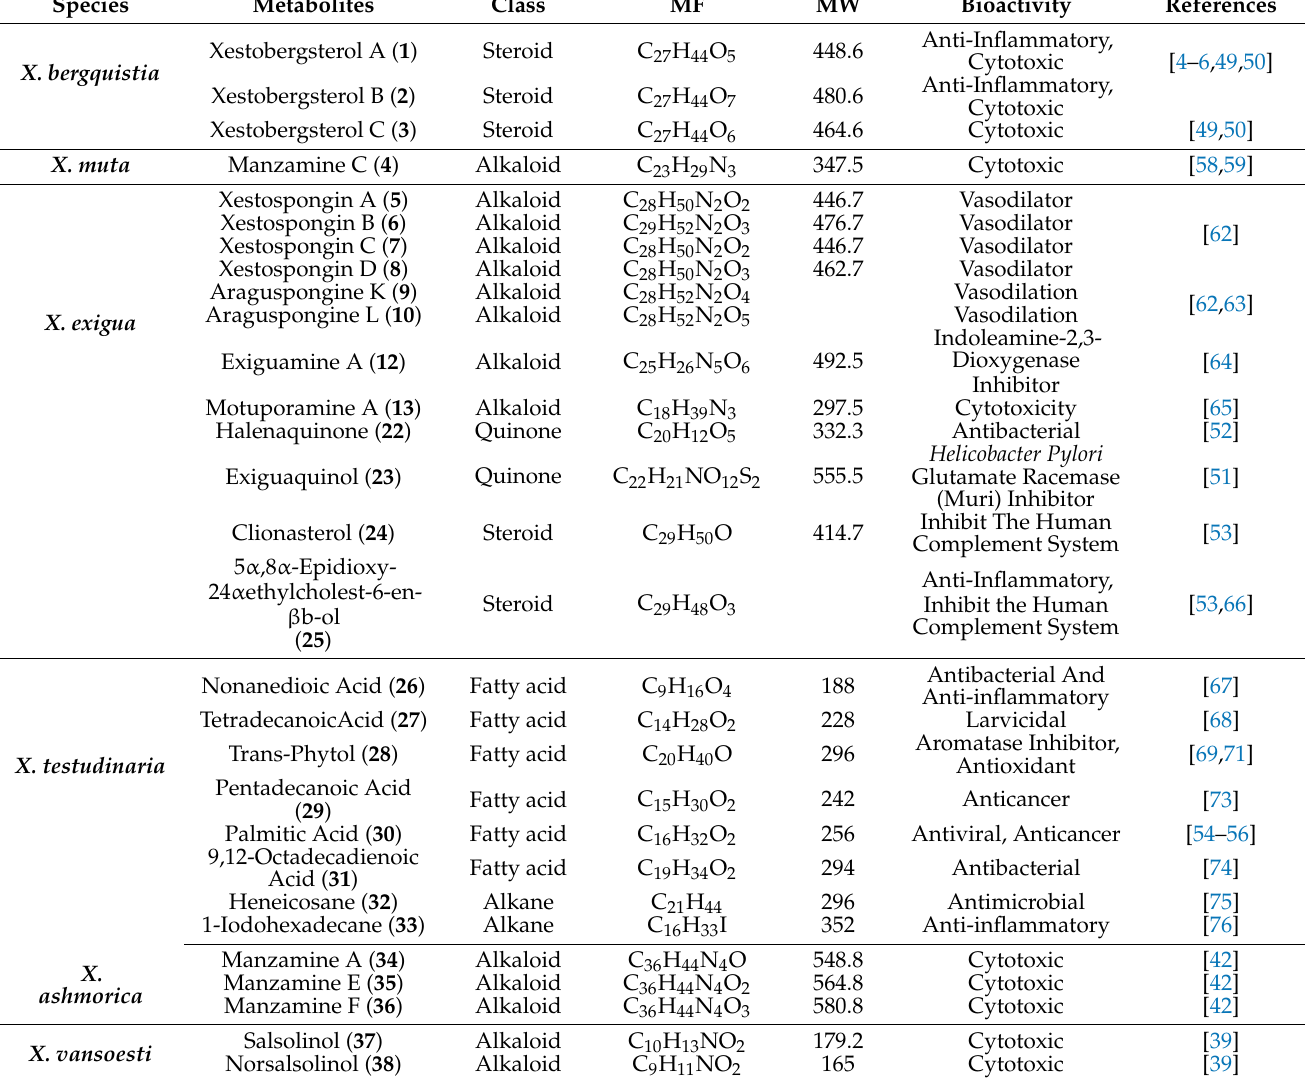
Table 1. Summary of bioactive metabolites isolated from Xestospongia